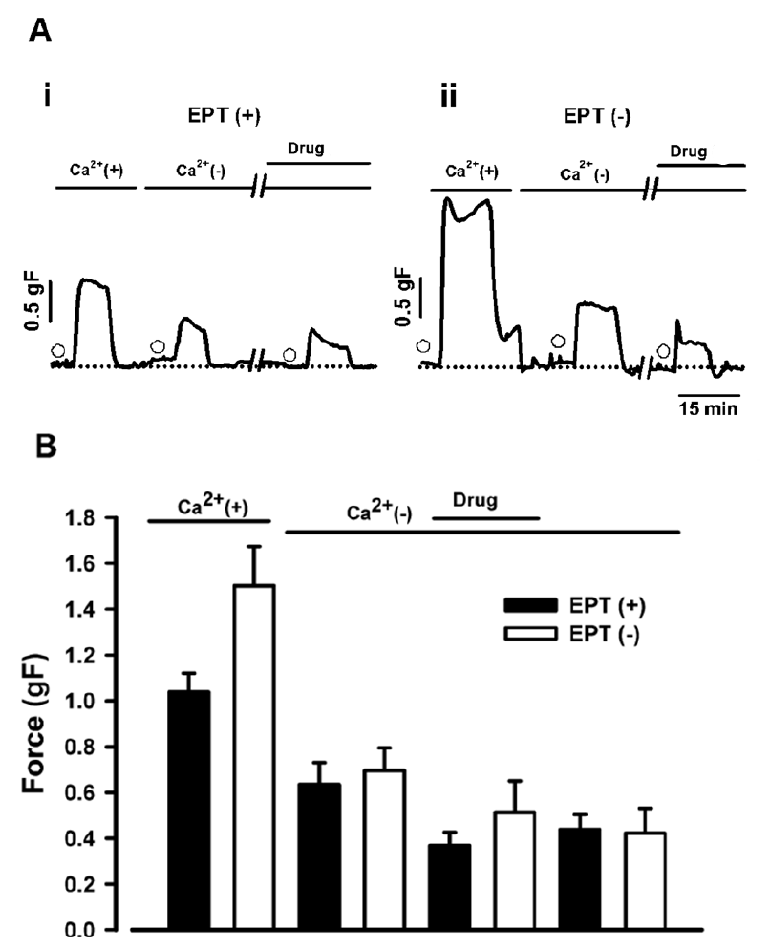
Figure 4. Effect of trans -caryophyllene on contractions induced by ACh on preparations maintained in Ca 2+ -free solution. ( A ) Examples of experimental traces obtained from segments where the epithelium is present (EPT(+), Ai ) or absent (EPT( − ), Aii ). Open circles indicate ACh application at 60 µM. ( B ) Bar graphs showing average of contraction force. Black bars represent mean ± S.E.M. (n = 8) for segments containing intact epithelium. Open bars represent mean ± S.E.M. (n = 8) for segments without intact